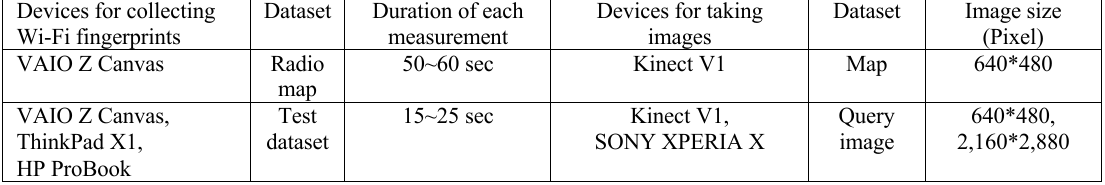
Table 1. Devices used in test.